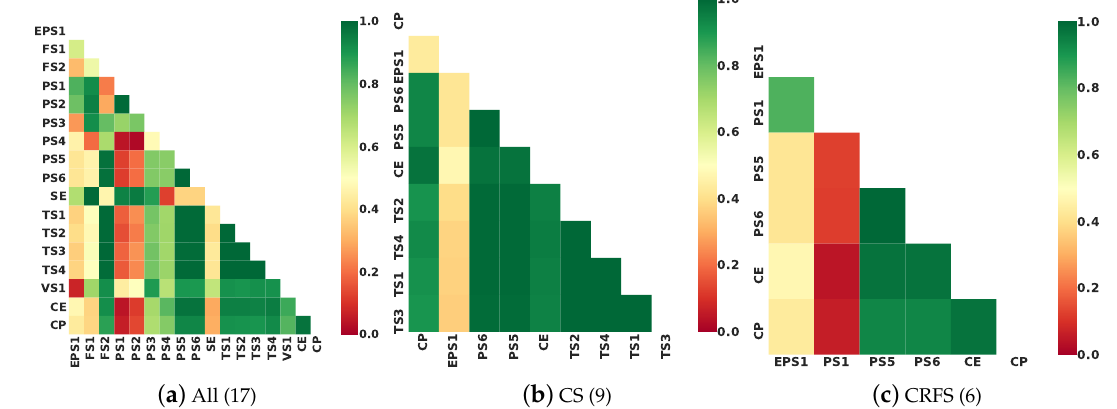
Figure 9. Feature-to-feature correlation on Accumulator fault label. Lower value represents less